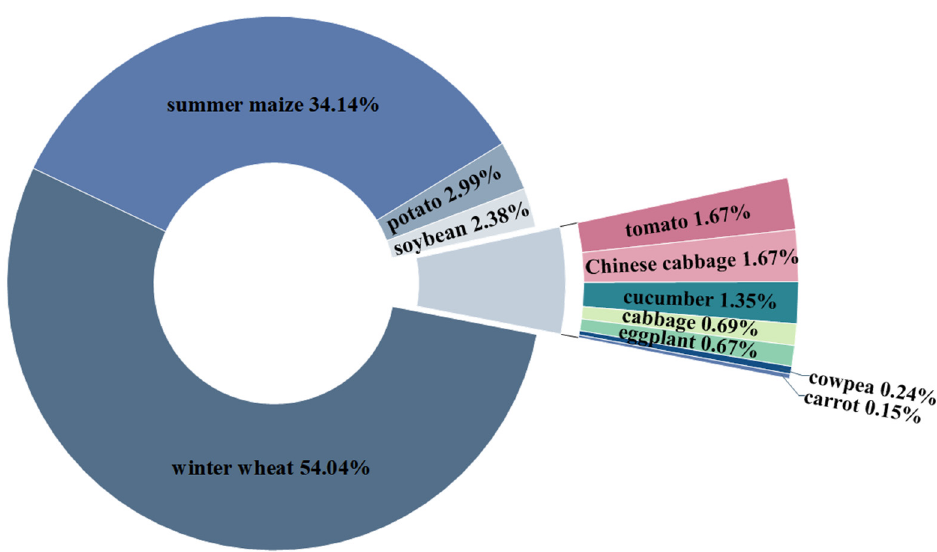
Figure 4. Annually average proportions of regional total irrigation water demand for major grain and vegetable crops in Hebei Province from 2007 to 2017